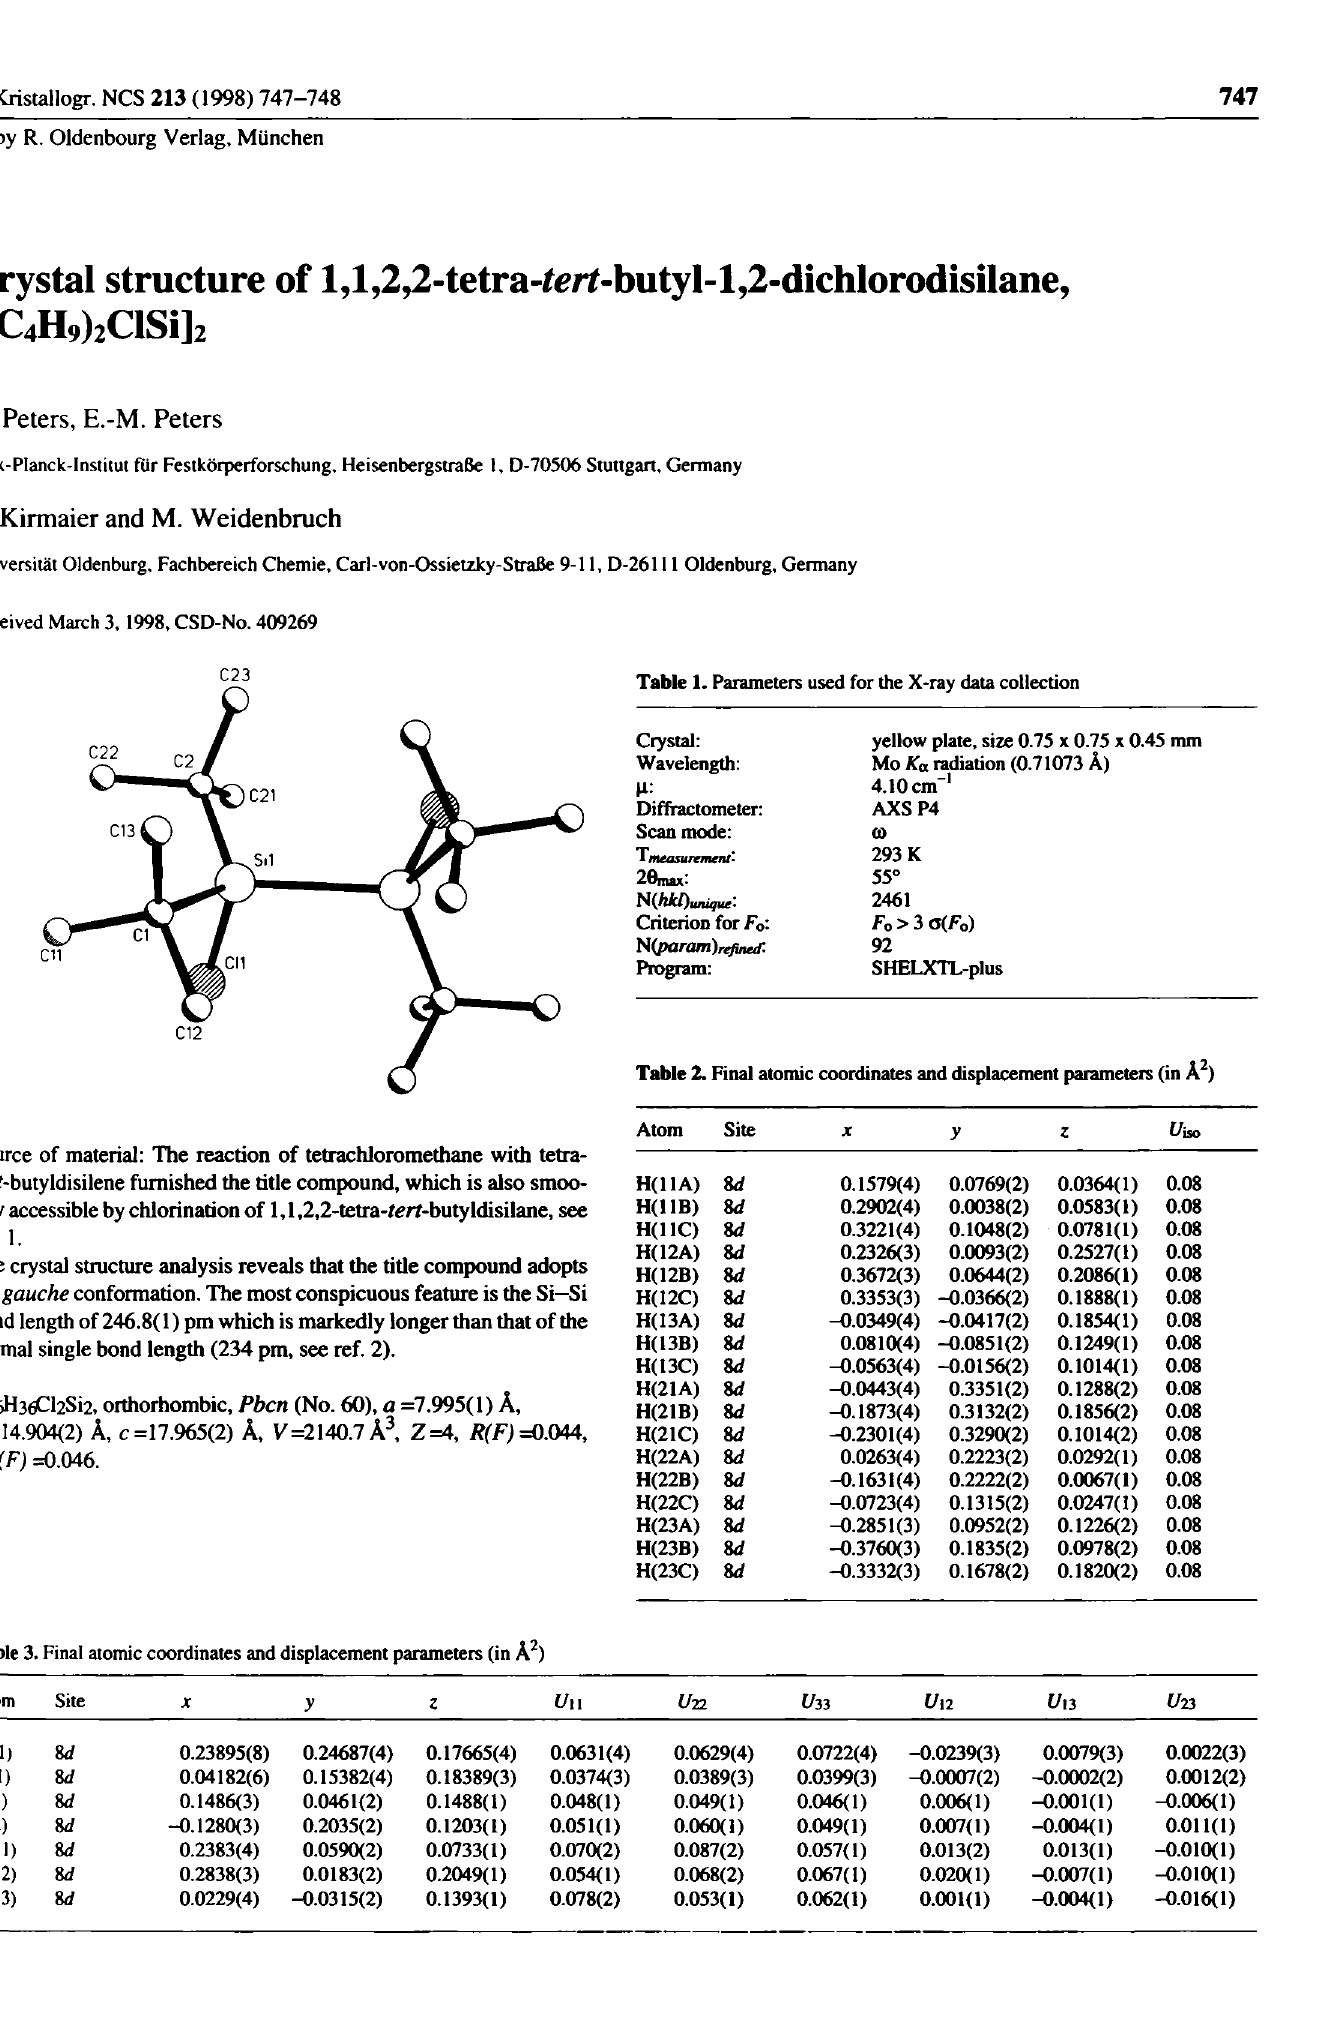
Table 1. Parameters used for the X-ray data collection C23